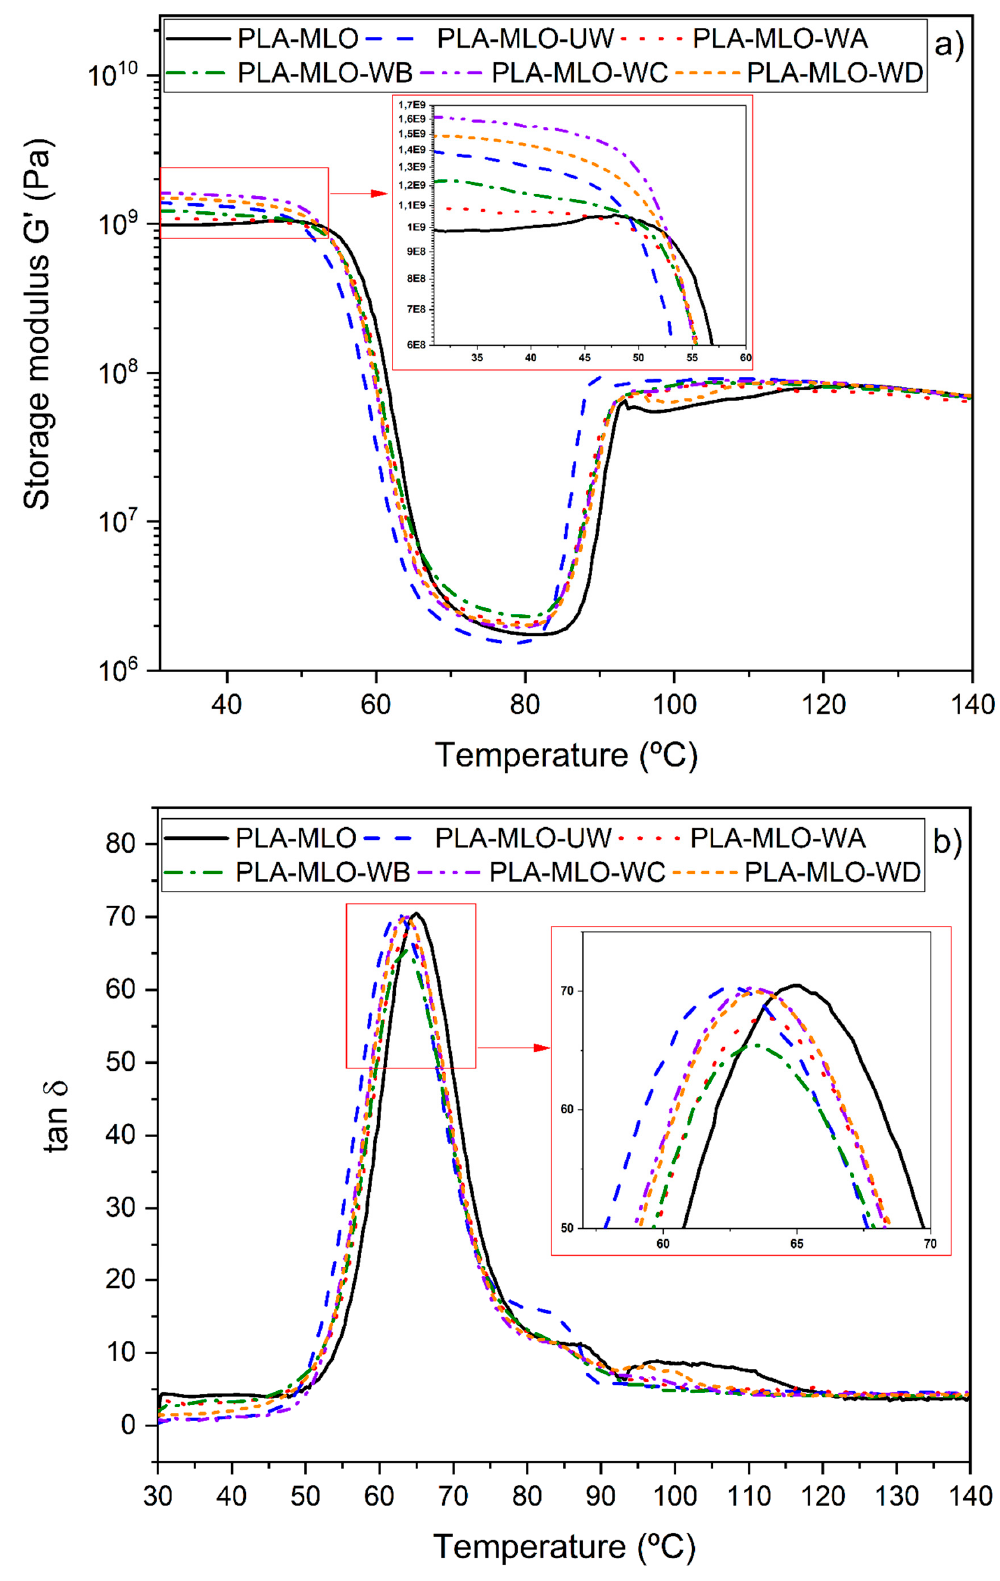
Figure 8. DMTA analysis curves: ( a ) storage modulus and ( b ) loss factor for PLA–wool FRP.